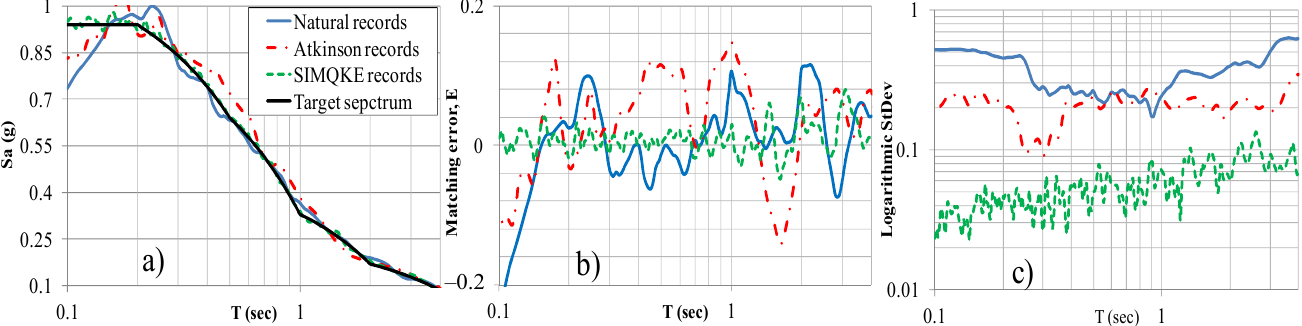
Figure 6. Comparison of the spectrum matching for different artificial and natural records for case of: ( a ) mean response spectra; ( b ) error in spectrum matching and ( c ) logarithmic standard deviation.